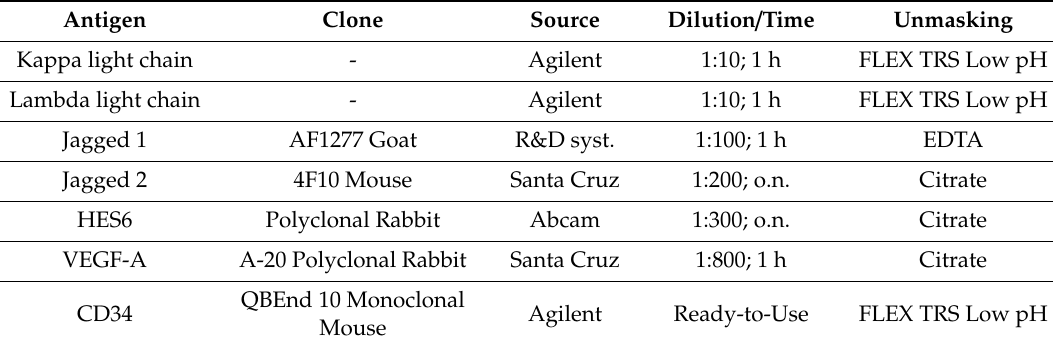
Table 3. Antibodies and experimental conditions used for the